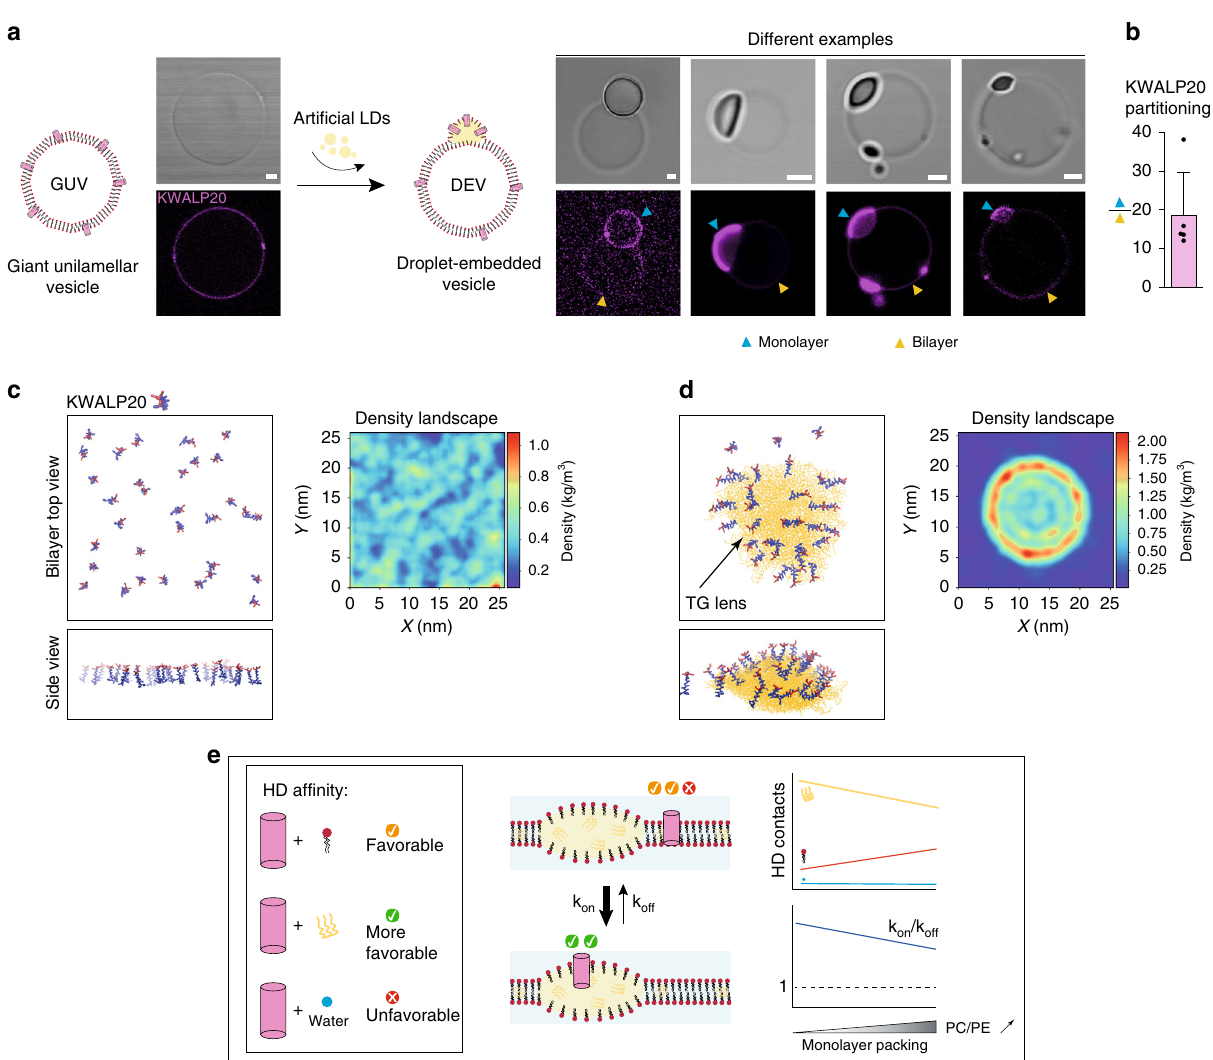
Fig. 6 Nascent LDs are attractive to monotopic proteins. a Formation of DEVs-containing KWALP20 labeled with Rh-B: (left) KWALP20 is inserted in GUVs, during GUV electroformation or by mixing GUVs with the peptide; an example of the resulting KWALP20-interted GUV is shown. (right) KWALP20-containing GUVs are mixed with a TG-in-buffer droplet to generate droplet-embedded vesicles; several examples of the resulting DEVs are displayed: The peptide is labeled with Rh-B. The KWALP signals on the monolayer and the bilayer are respectively depicted by blue and yellow arrows. Strong accumulation happens at the monolayer. Image brightness is enhanced to improve monolayer viewing. Scale bar: 2 µ m. b The ratio between monolayer and bilayer signals is plotted as mean ± SD ( n = 5 independent measurements). Individual points are indicated. Source data are provided as a Source Data fi le. c , d Left: snapshot of molecular dynamics simulations of a bilayer with 32 KWALP20 peptides in parallel orientation, in the absence ( c ) and the presence ( d ) of a TG lens. Hydrophobic amino-acids are represented in blue and charged ones (lysines) in red. On the right of each simulation is displayed the average protein density pro fi les in the bilayer plane, averaged over the entire MD simulation (20 μ s), in the absence ( d ) and in the presence ( e ) of the TG lens. e Basic model of how the different interactions of an HD favor its LD monolayer accumulation. HD interacts with TG, phospholipids or water; the monolayer packing regulates the contact between these species and tunes the reaction constant k on / k off